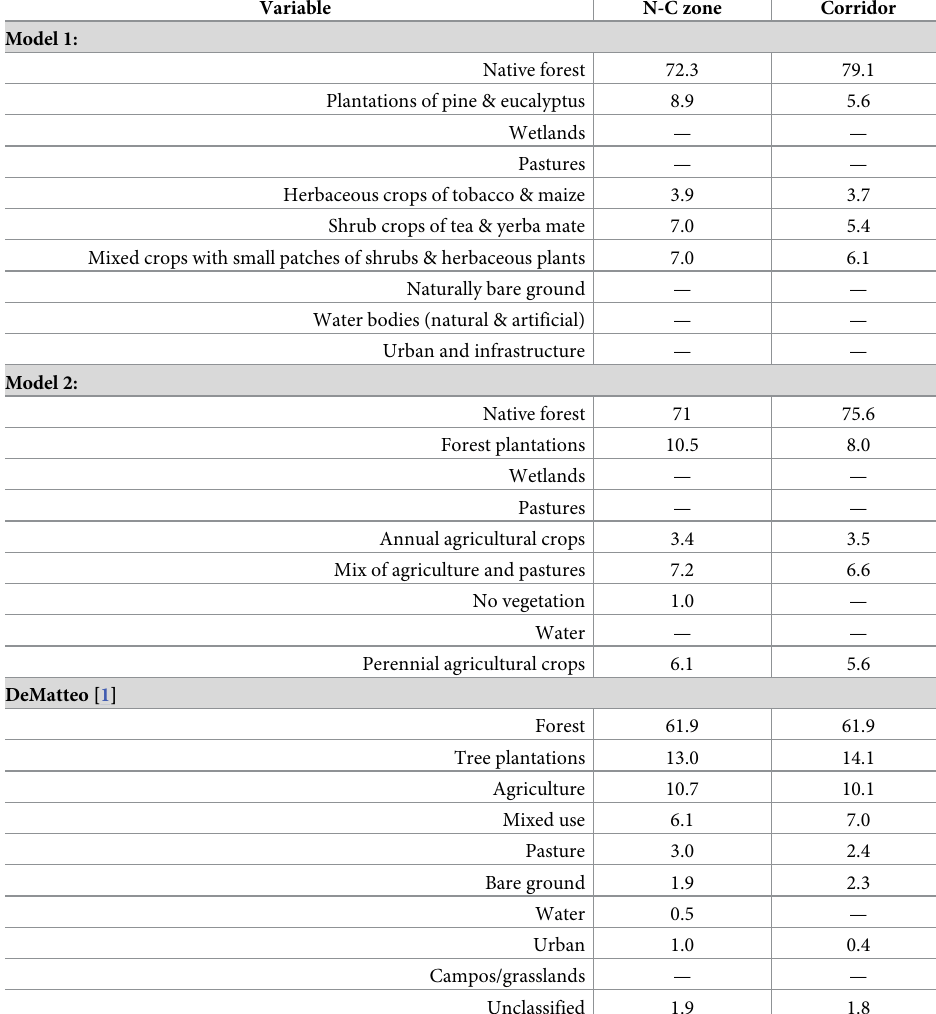
Table 5. Proportion (%) of native forest and modified environments for the northern-central (NC) zone in Mis- iones, Argentina, and the ~400,000 ha multispecies biological corridor modelled by DeMatteo